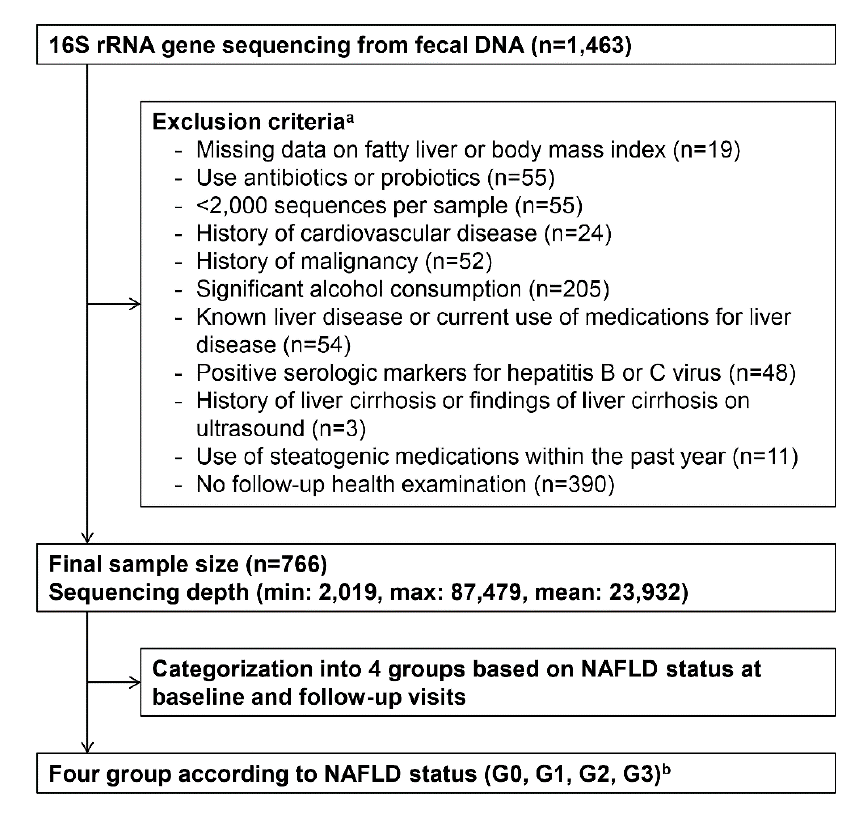
Figure 1. Enrolment of subjects. Inclusion criteria: 1463 Korean adults aged 23 to 78 years who agreed to participate in this study and provided stool samples at Kangbuk Samsung Hospital Healthcare Screening Center out of those who underwent annual or biennial examinations during the study period between June 2014 and September 2014. a Some individuals met several exclusion criteria. b G0, none (control), patients without fatty liver both at baseline and follow-up; G1, developed, patients without fatty liver at baseline but with fatty liver at follow-up; G2, regressed, patients with fatty liver at baseline but without fatty liver at follow-up; G3, persistent, patients with fatty liver both at baseline and follow-up.